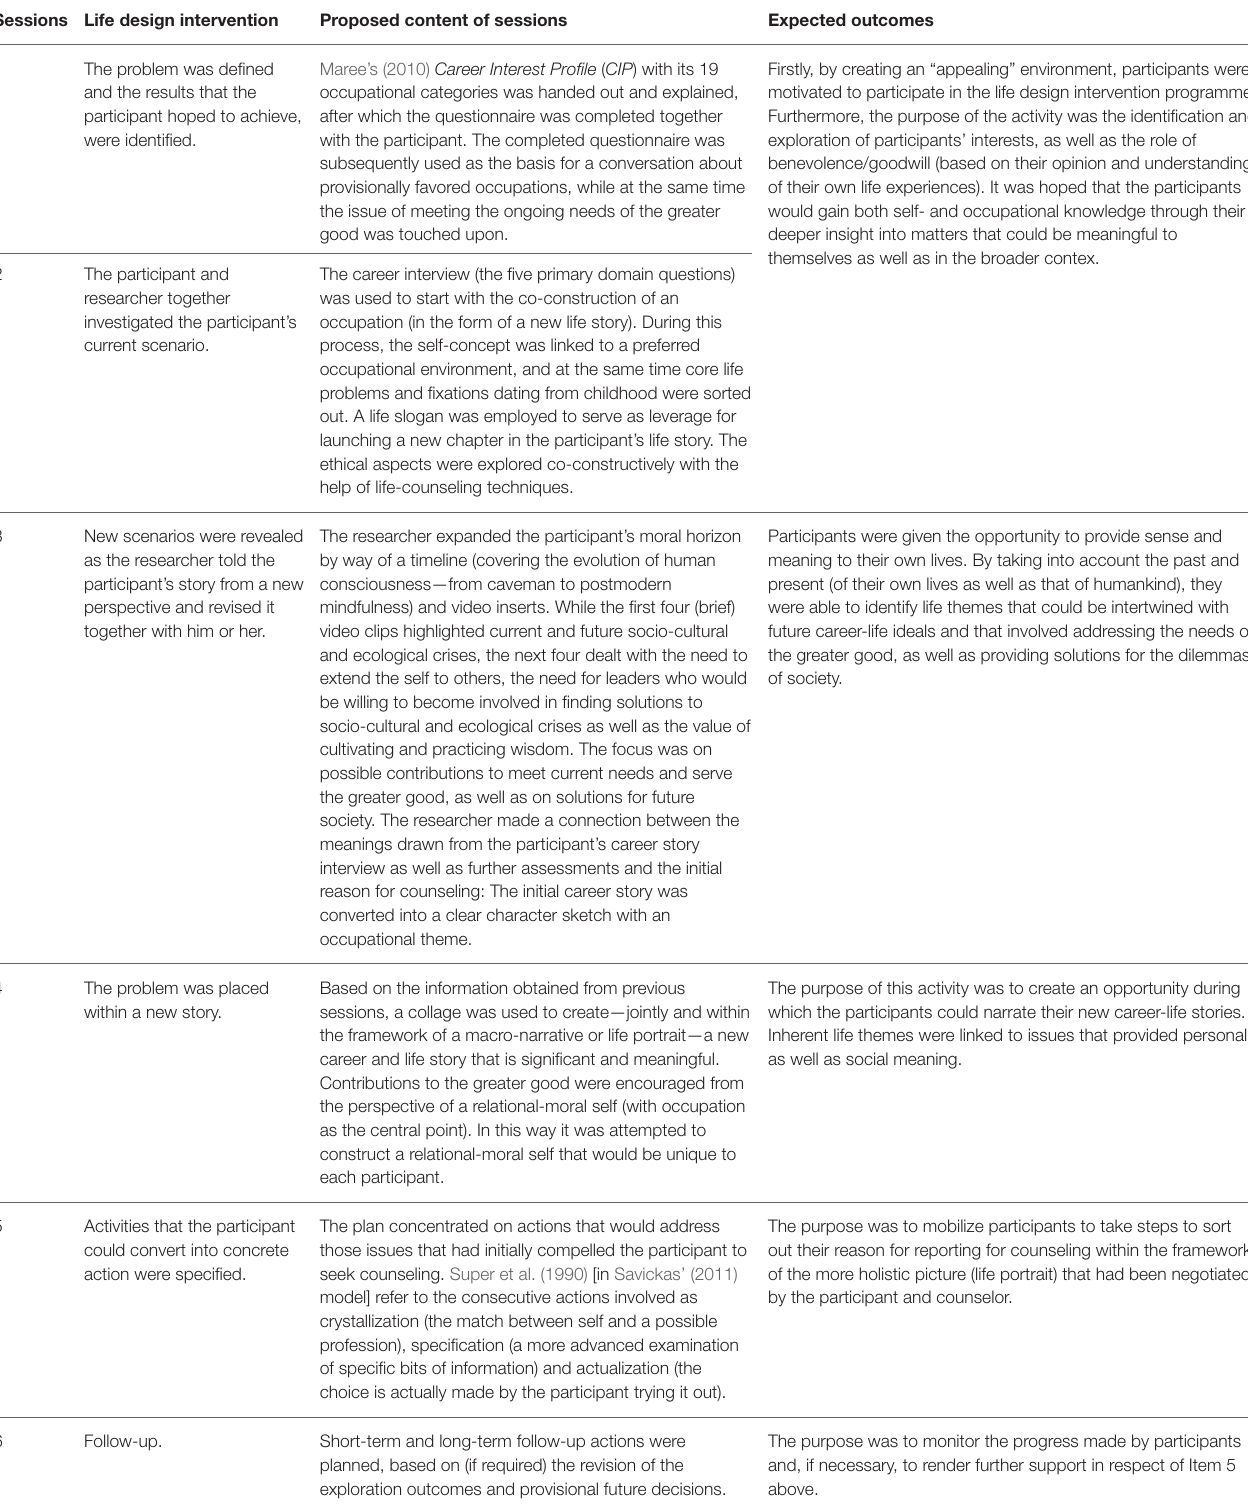
TABLE 2 | Description of the